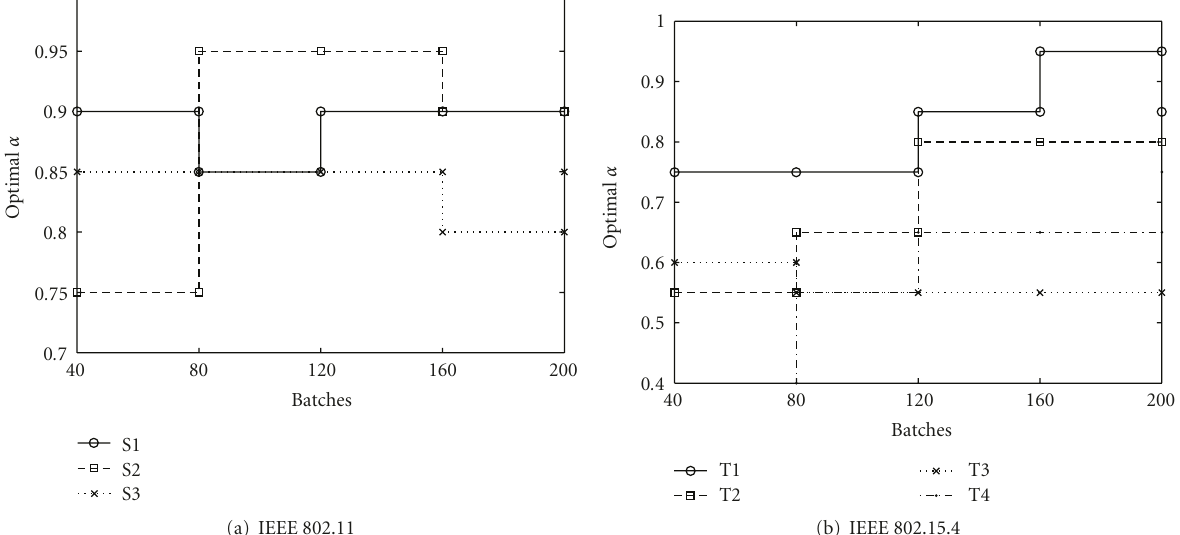
Figure 13: The best α with time for IEEE 802.11 and IEEE